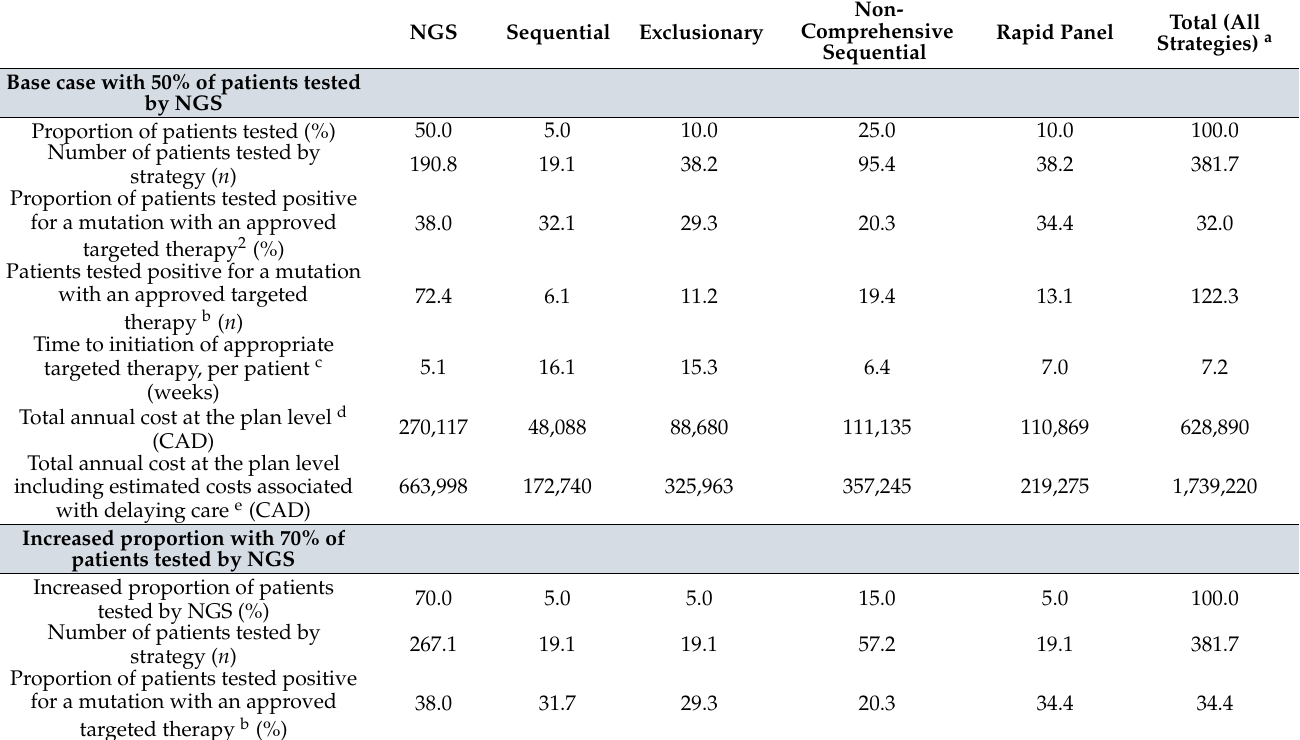
Table 4. Impact of increasing the proportion of patients tested with